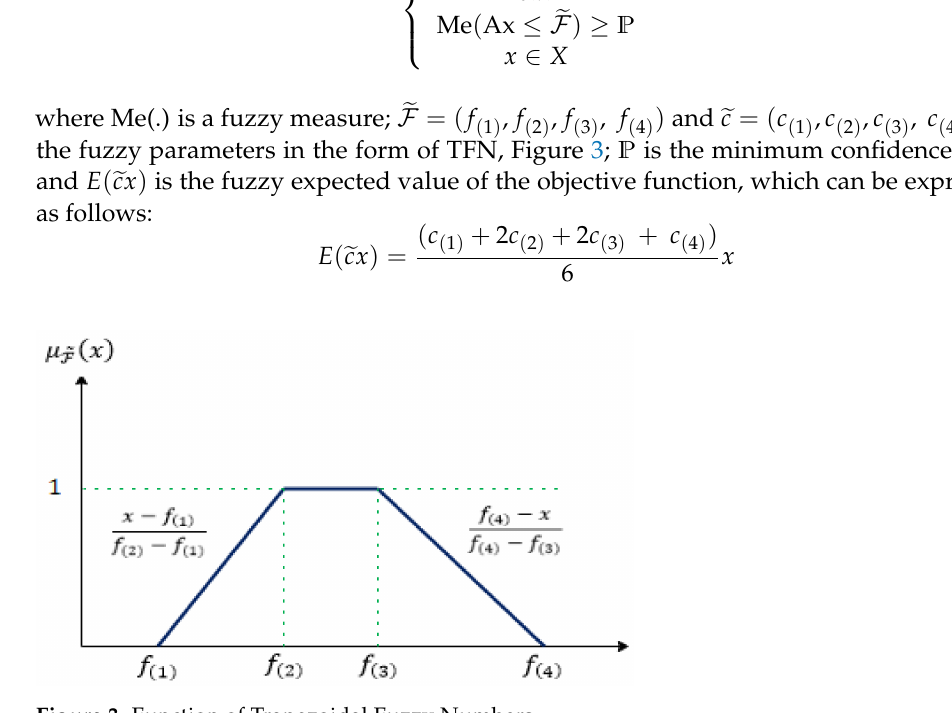
Figure 3. Function of Trapezoidal Fuzzy